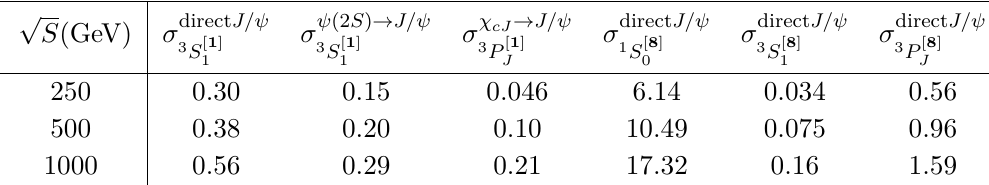
Table 2 . The integrated cross sections (in unit of pb) from various channels for J/ψ photoproduc- tion under different collision energies at the ILC. The cut p t > 5 GeV is set for J/ψ